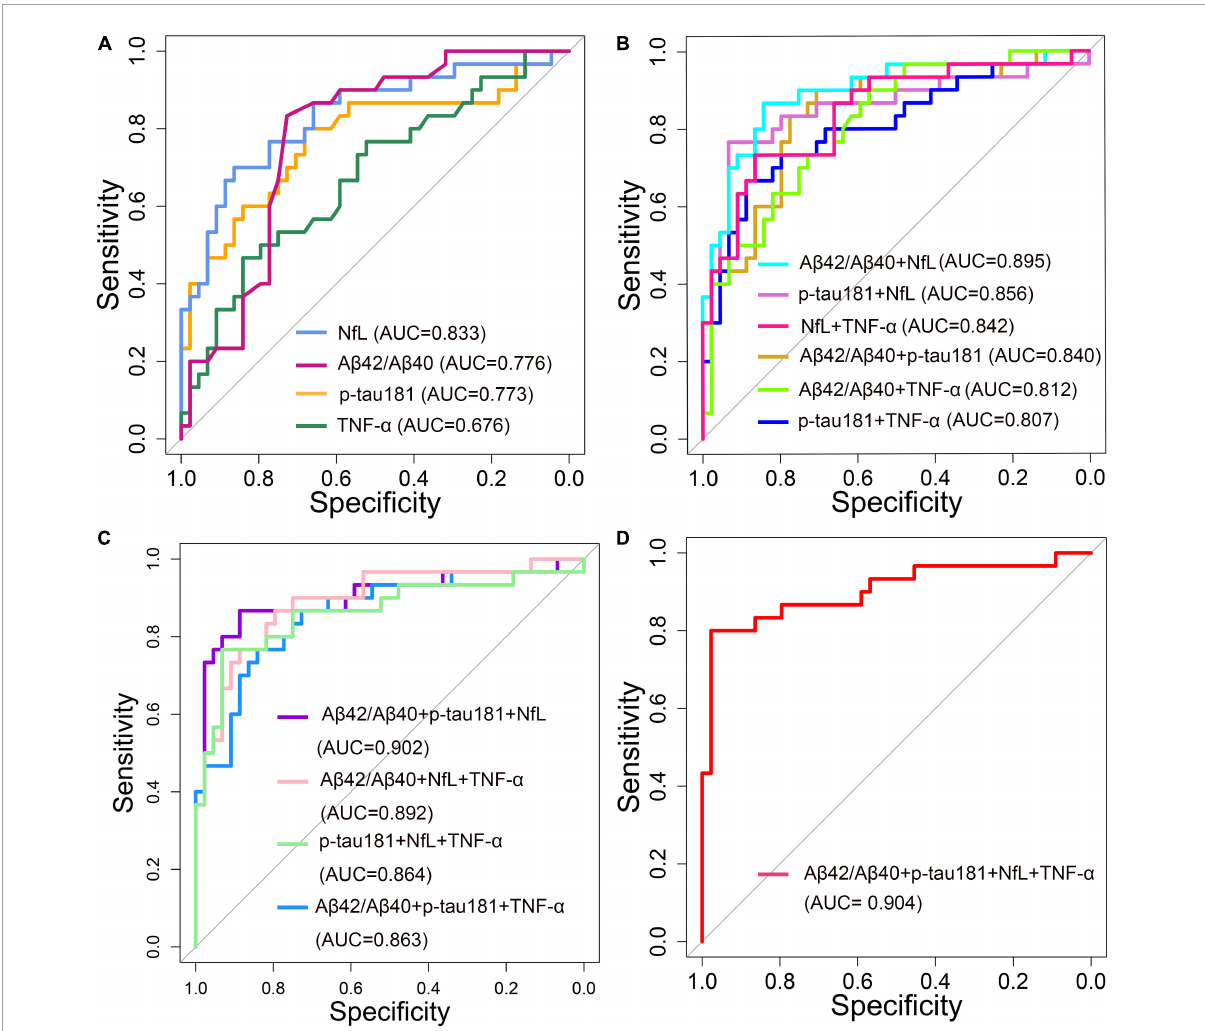
FIGURE6 Receiver operating characteristic (ROC) curve analyses of plasma ANT biomarkers and inflammatory factors for distinguishing Alzheimer’s disease (AD) dementia from normal control (NC) of 74 patients (30 AD dementia and 44 NC). (A) Single biomarker (A β 42/A β 40, p-tau181, NfL and TNF- α ) were used as a predictor, respectively. (B) Two composite biomarkers (A β 42/A β 40 ratio + p-tau181, A β 42/A β 40 ratio + NfL, A β 42/A β 40 ratio + TNF- α , p-tau181 + NfL, p-tau181 + TNF- α , NfL + TNF- α ) were used as a predictor, respectively. (C) Three